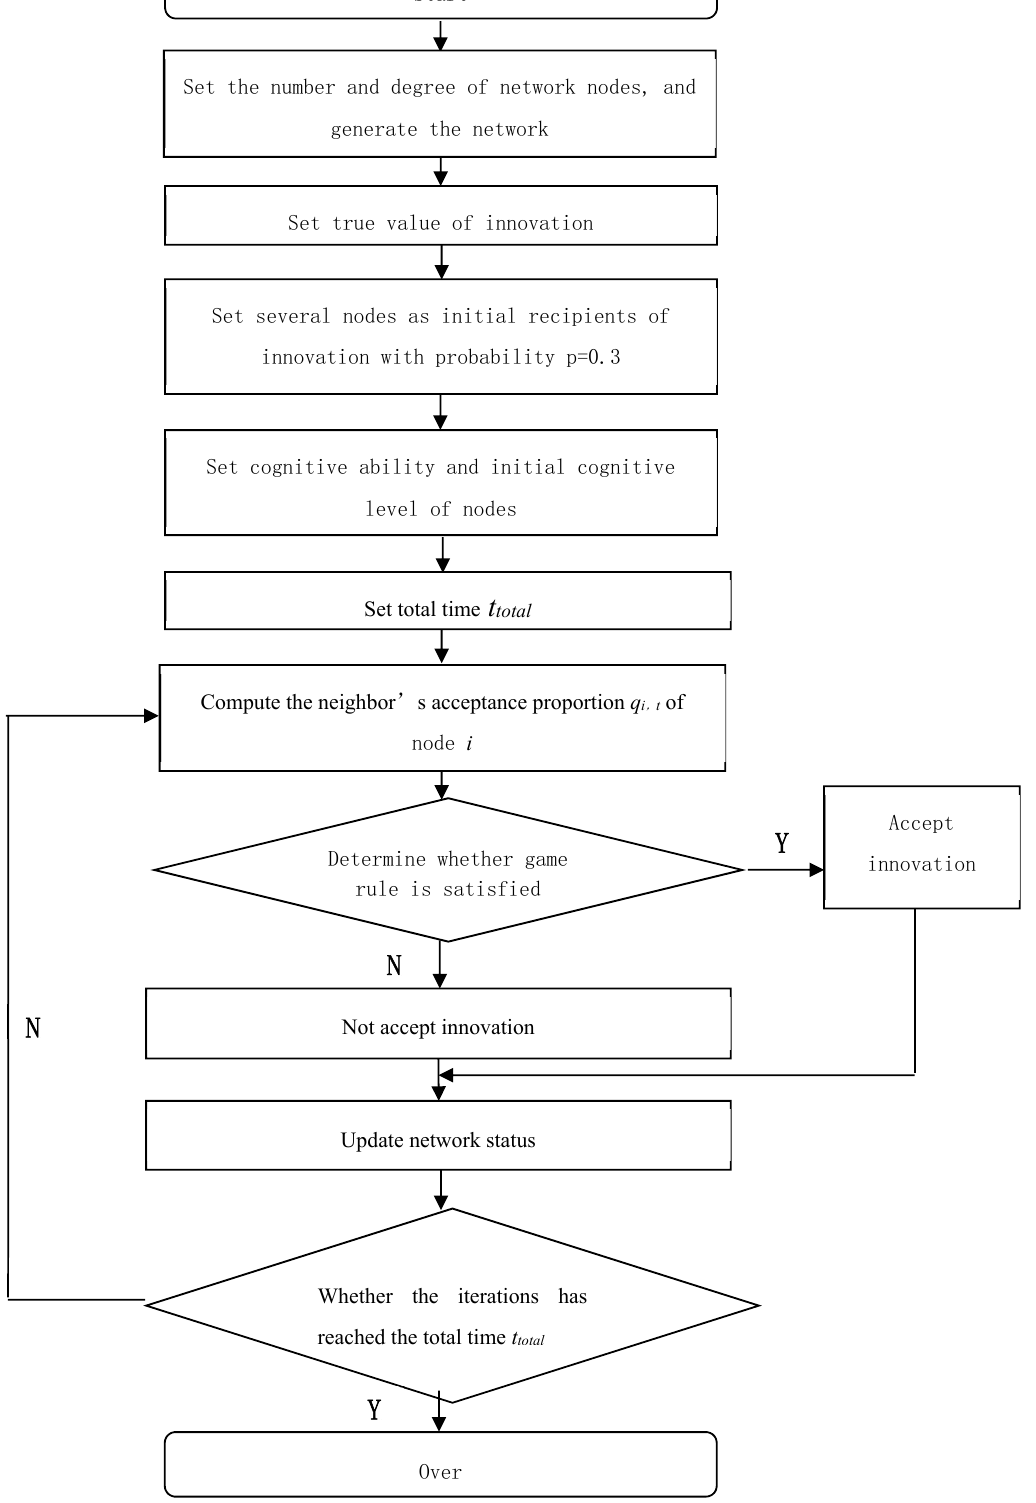
Figure 3. Simulation process diagram.